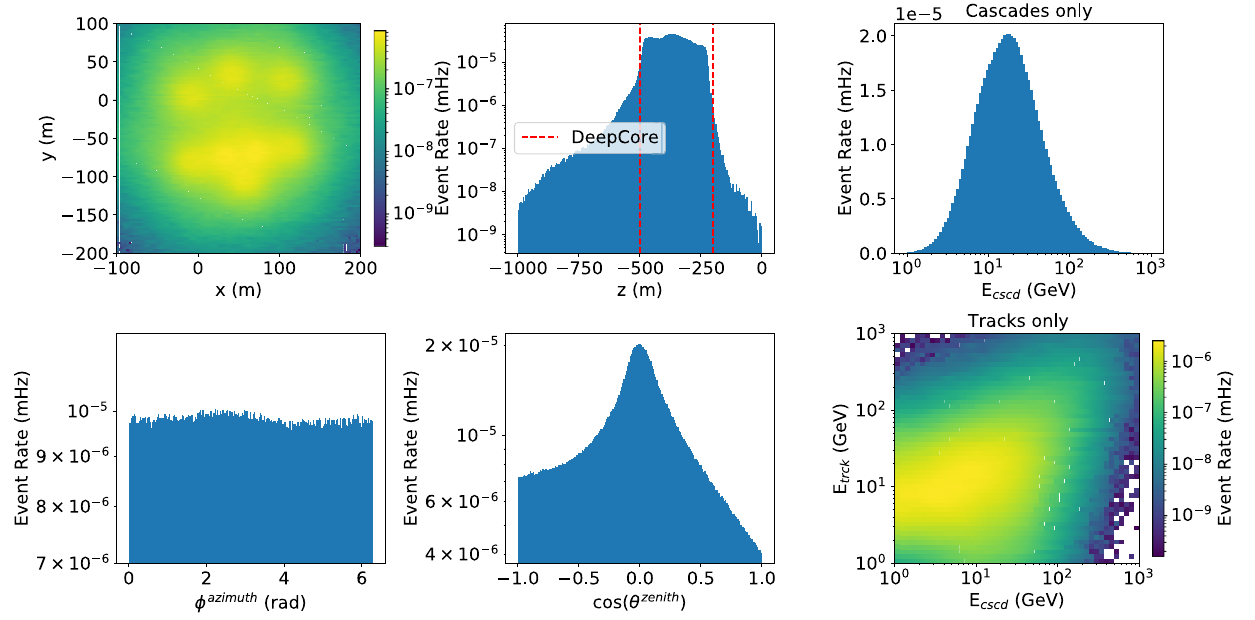
Fig. 20 True parameter distributions of the full test event sample after the selection process weighted by the atmospheric flux and oscillation probability.Thepositionandangulardistributionscontainallevents,the